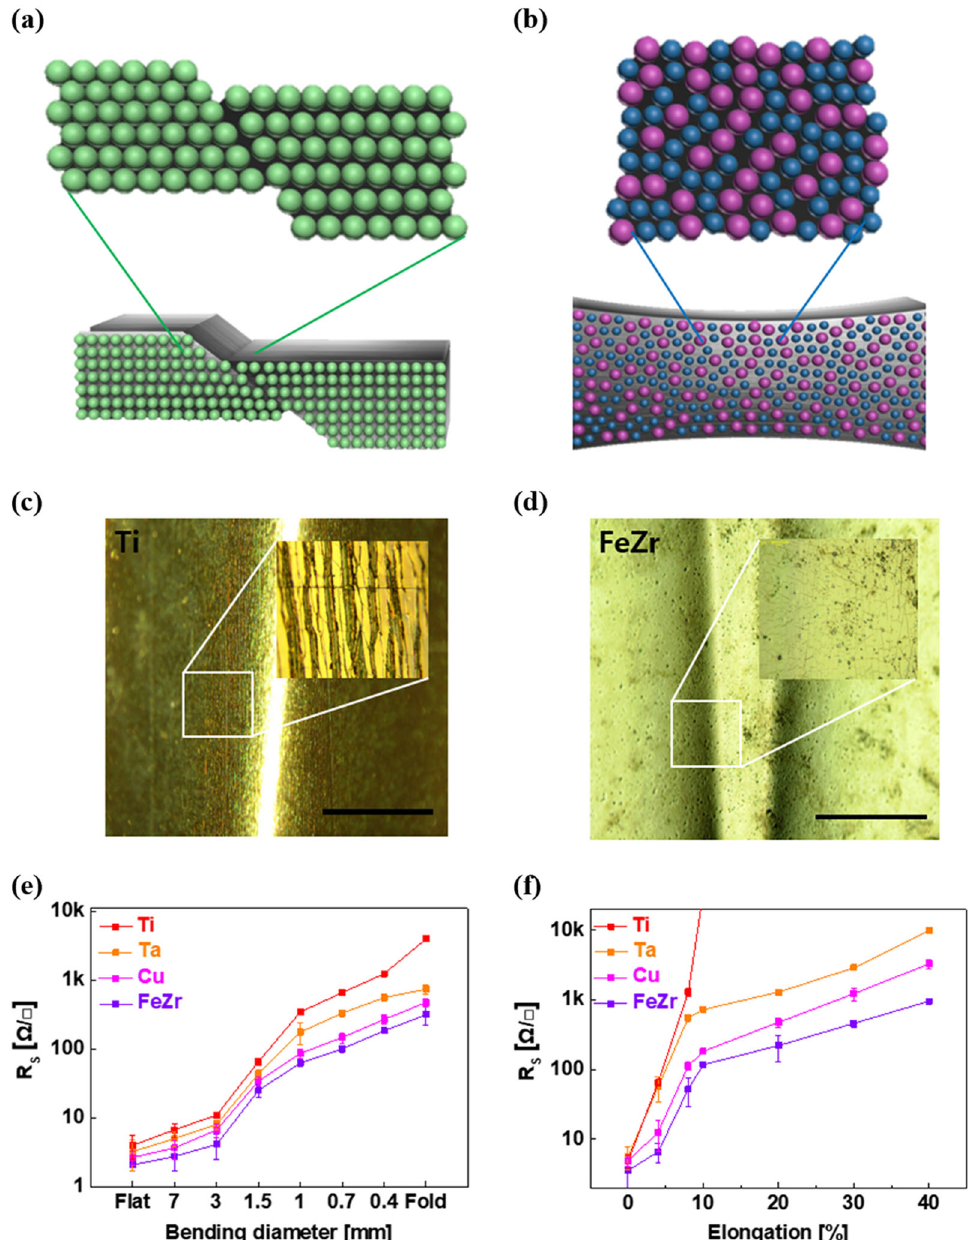
Fig. 1 Comparison of amorphous metal and crystalline metal. Structural deformation diagram according to external force of a crystalline metal and b amorphous metal. Optical images of c Ti and d FeZr thin fi lm under bending situation. Inset shows magni fi ed view. Scale bar is 1 mm. Sheet resistance of various metal thin fi lms with e bending diameter and f use as a counter electrode. Given that a PDMS microstructure is fl exible, the pyramidal structure will be deformed under mechan- ical stimuli. With the change in the contact area between the